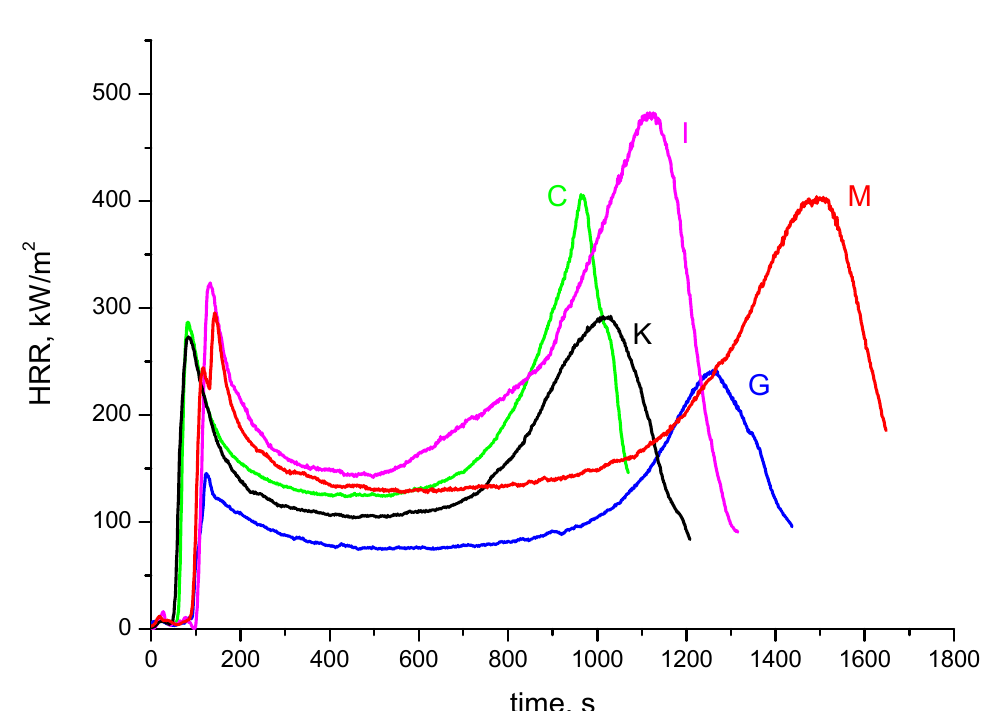
Figure 5. The average HRR–time runs for untreated samples at 35 kW/m 2 ; C—Cumaru, G—Garapa, I—Ipe, K—Kempas, M—Merbau.